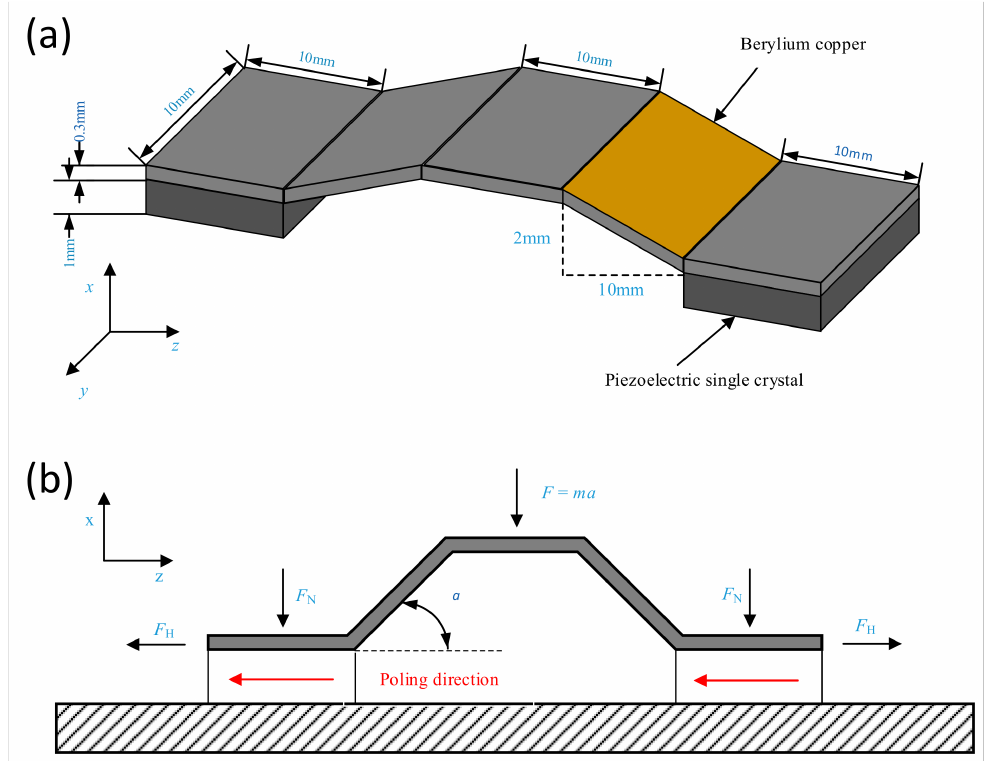
Figure 6. Working principle of the BSPEH. ( a ) Schematic of the energy harvester and ( b ) Mechanical analysis of the structure